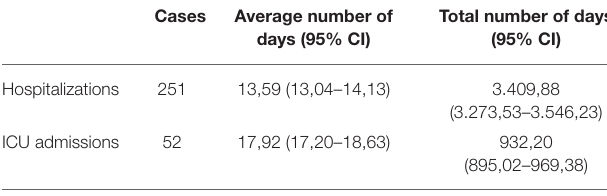
TABLE 5 | Number of days of hospitalizations based on the average number of days per patient in hospitals.